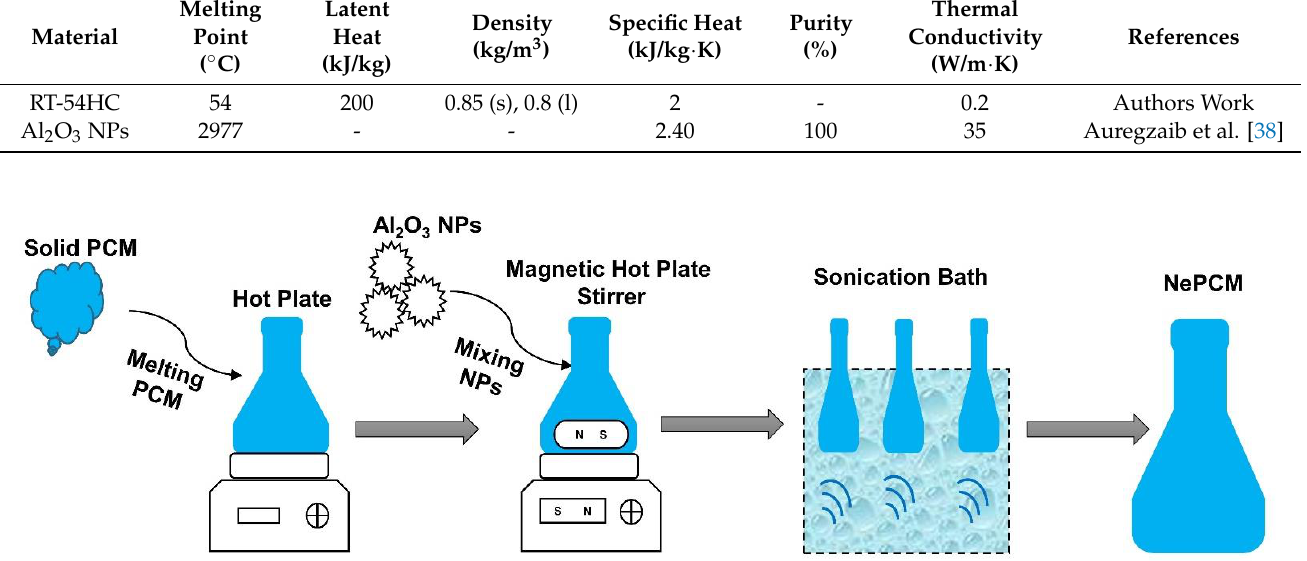
Figure 4. Sequence of steps for NePCM preparation.